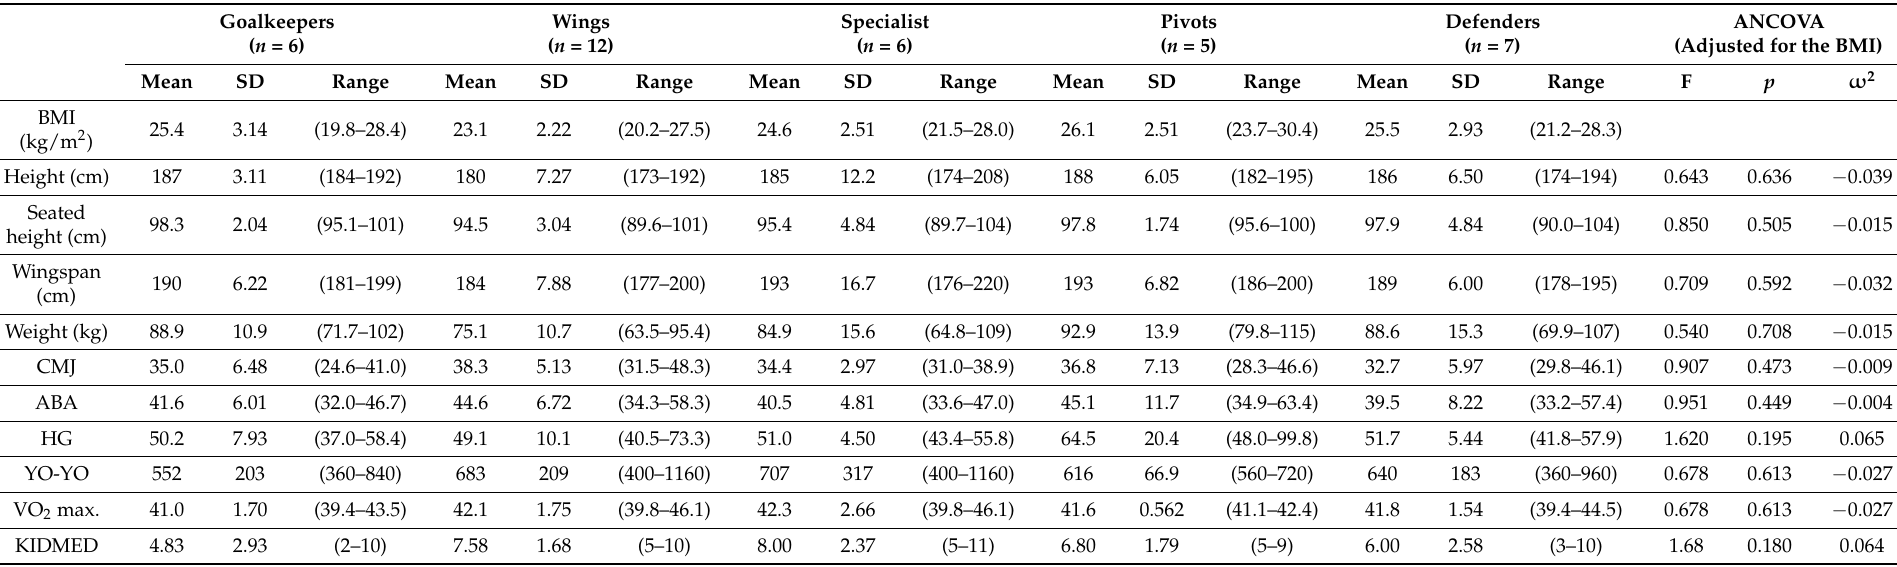
Table 3. Differences, according to the playing